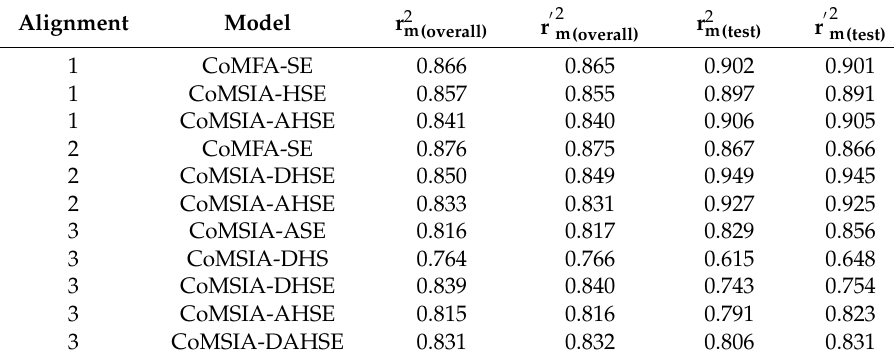
Table 1. The r 2 m metrics values of the selected